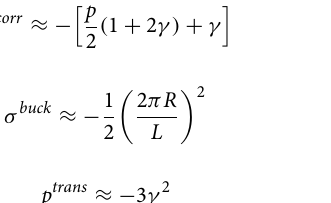
1 / 50 . High symmetry phase is located = 1 / 25 . The set of = 1 / 25 , dashed line γ 1 / 250 , dotted line γ 0 = = = κ/ E 2 D R 2 . For the sake of clarity, we consider the tube = (cid:31)